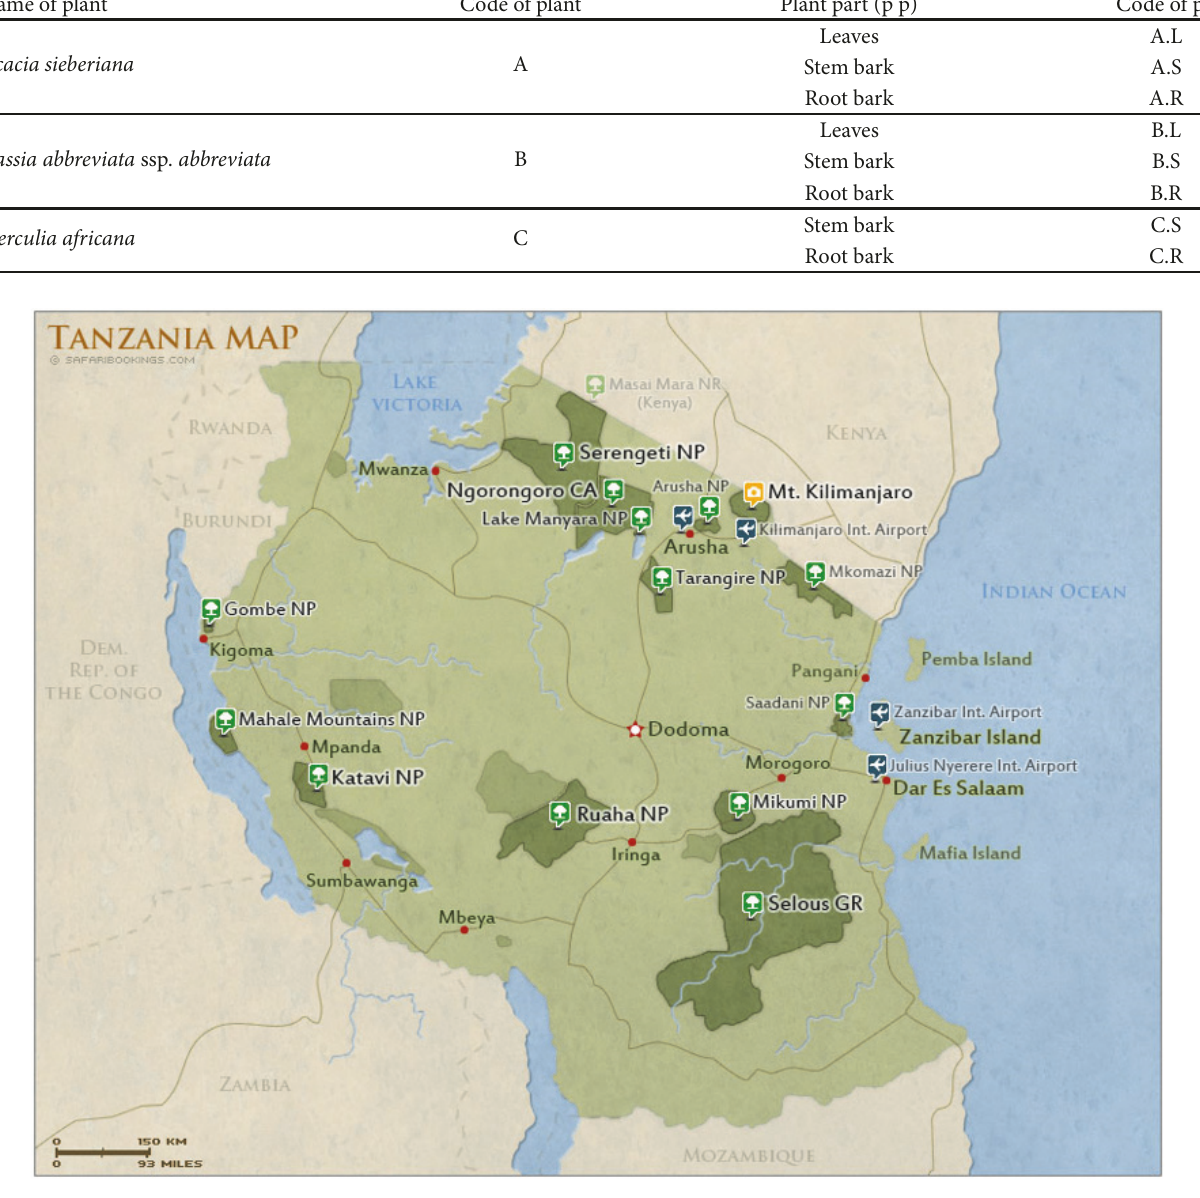
Figure 1: A map of Tanzania showing the location of Mikumi National Park and Morogoro